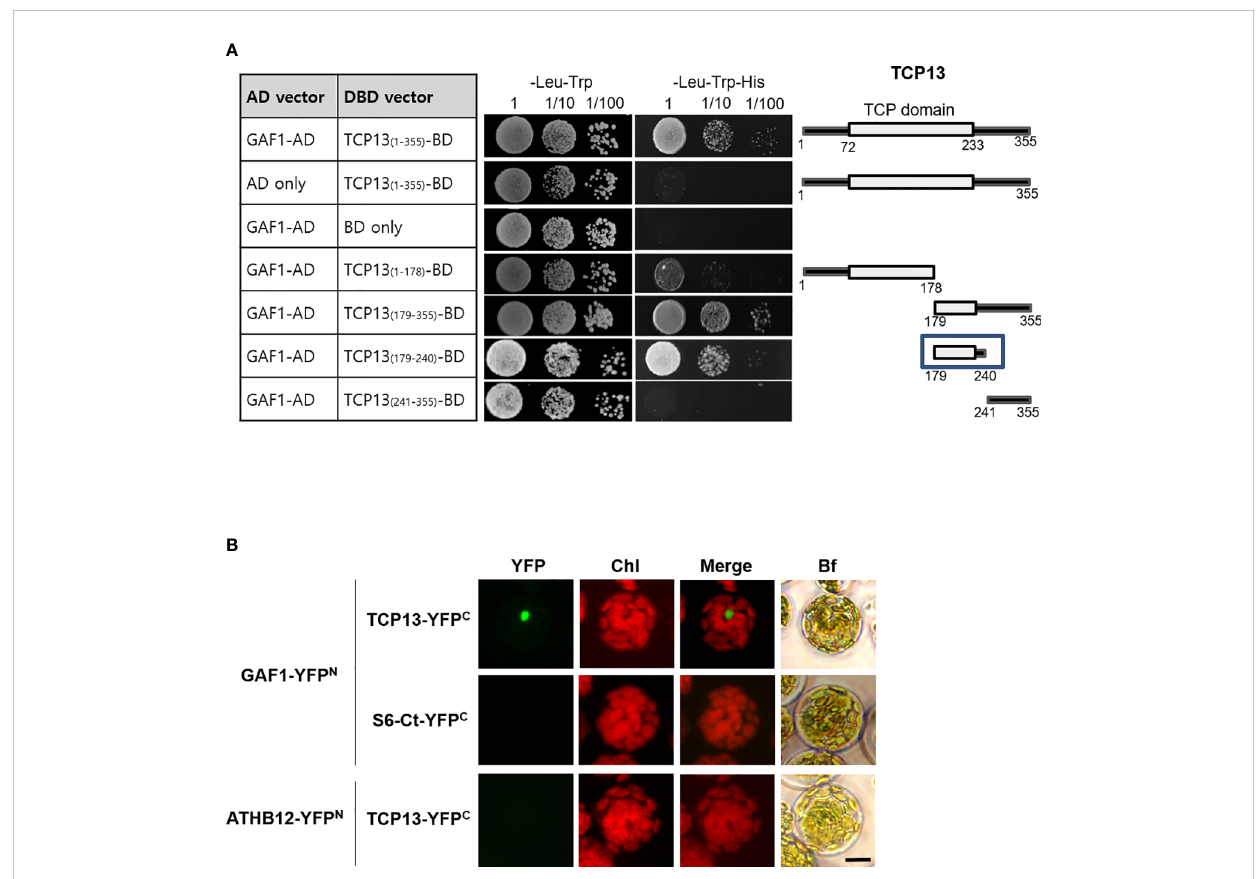
FIGURE 6 Interaction of TCP13 with GAF1. (A) Different regions of TCP13 were tested for the interaction with GAF1 in yeast two-hybrid assay. The DNA-binding domain (DBD) of GAL4 was fused to different regions of TCP13 while the activation domain (AD) of GAL4 was fused to GAF1. Co-transformed yeasts were selected on media lacking Leu and Trp (-Leu-Trp), and selected on media lacking Leu and Trp and His (-Leu-Trp-His) with or without 1 mM 3- amino-1,2,4 triazole (3-AT). The minimal region of TCP13 required for the interaction with GAF1 was indicated as a box. (B) Bimolecular fl uorescence complementation (BiFC) analysis of interaction between TCP13 and GAF1. Arabidopsis protoplasts were co-transfected with several combinations of the constructs of P 35S ::GAF1-YFP N and P 35S ::TCP13-YFP C . S6-Ct-YFP C : truncated RPS6 fused to YFP. A transcription factor ATHB12 fused to the N- terminal fragment of YFP (ATHB12-YFP N ) was used as negative control. Bf, bright fi eld. BiFC experiments were replicated three times with similar results. Scale bar = 10 m